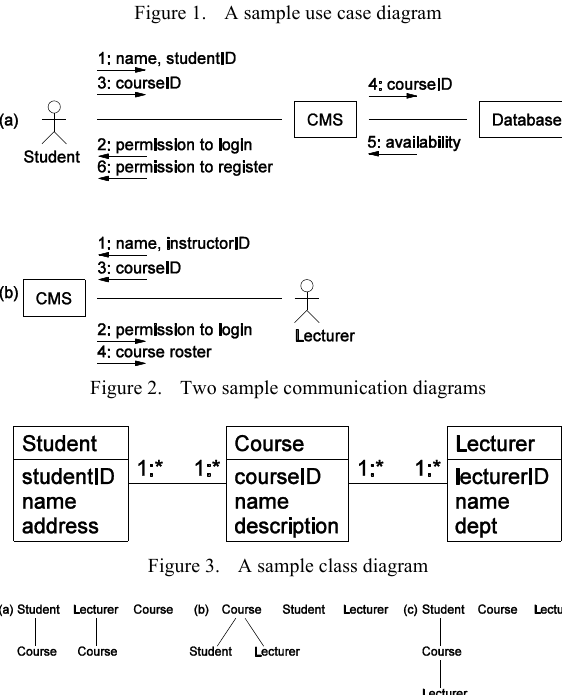
Figure 1. A sample use case diagram